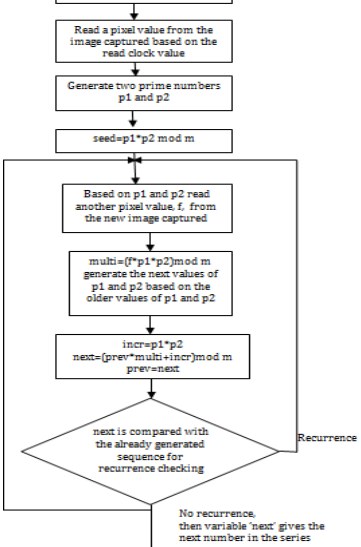
Figure 1. Flowchart of the proposed